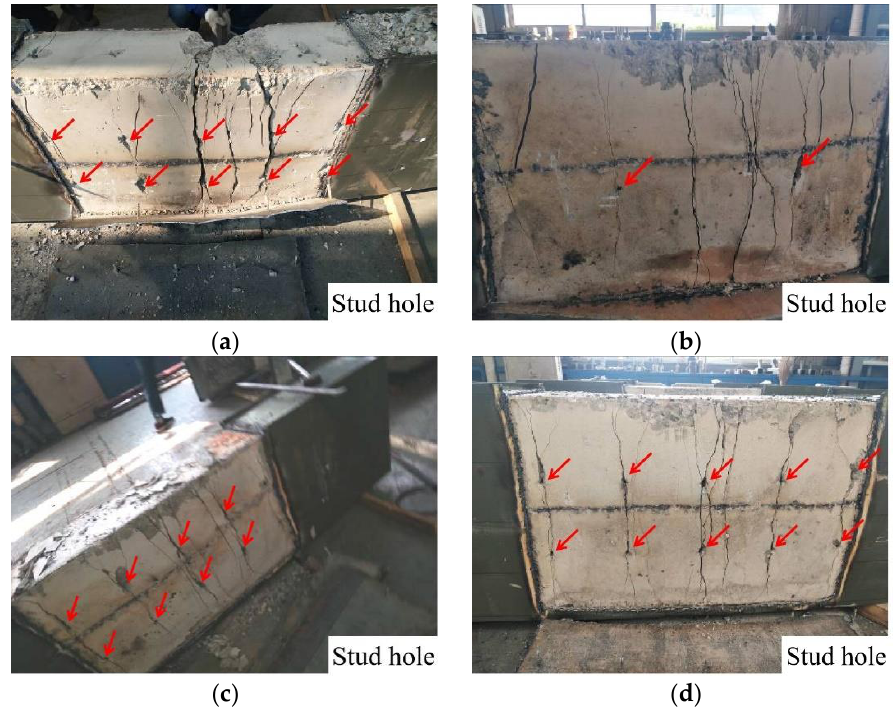
Figure 8. The cracking and stud holes of concrete in the tension zone on the bottom of the slabs: ( a ) S-2; ( b ) S-3; ( c ) S-6; ( d ) S-7.